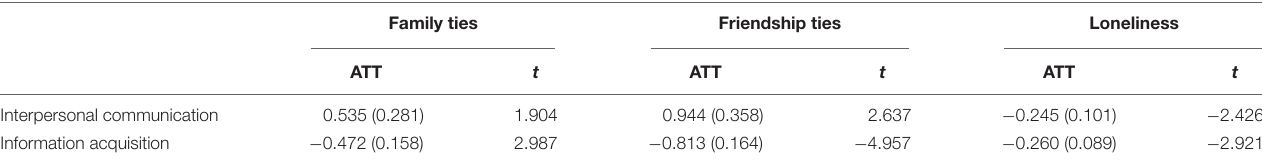
TABLE 5 | Propensity score matching of two types of Internet use.